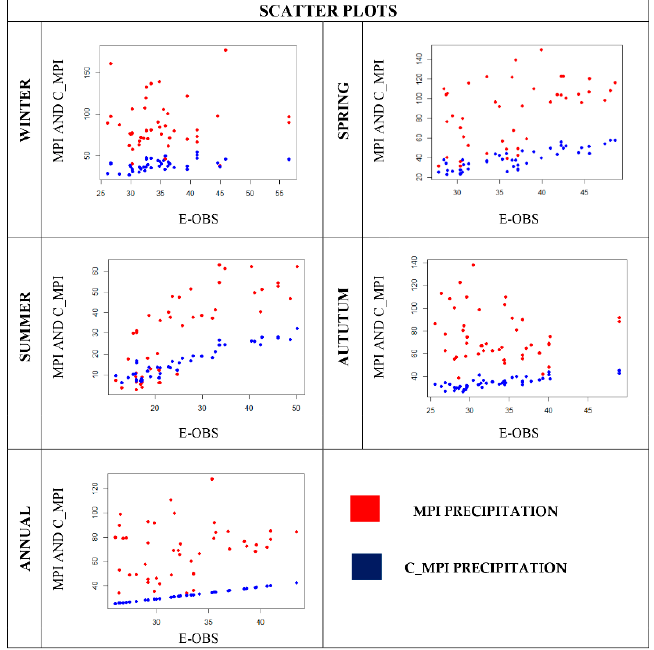
Figure 8. Scatterplots of the three studied datasets for the four seasons and for the whole studied